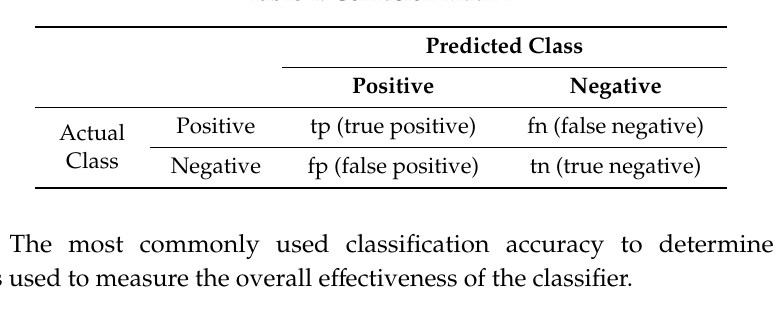
Table 4. Confusion Matrix.